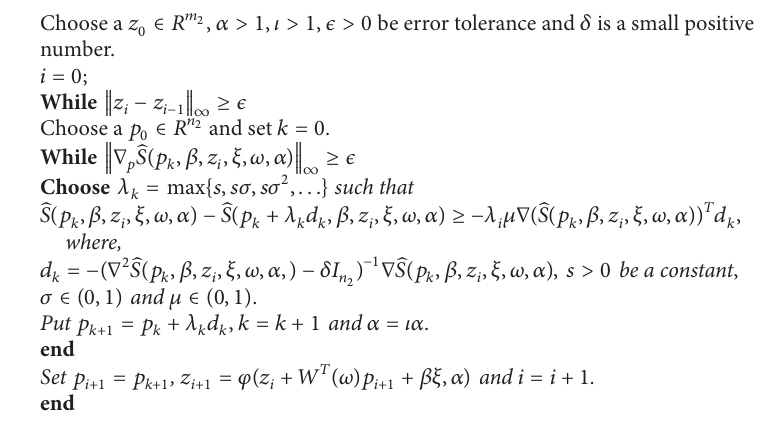
Algorithm 1: Newton method with the Armijo